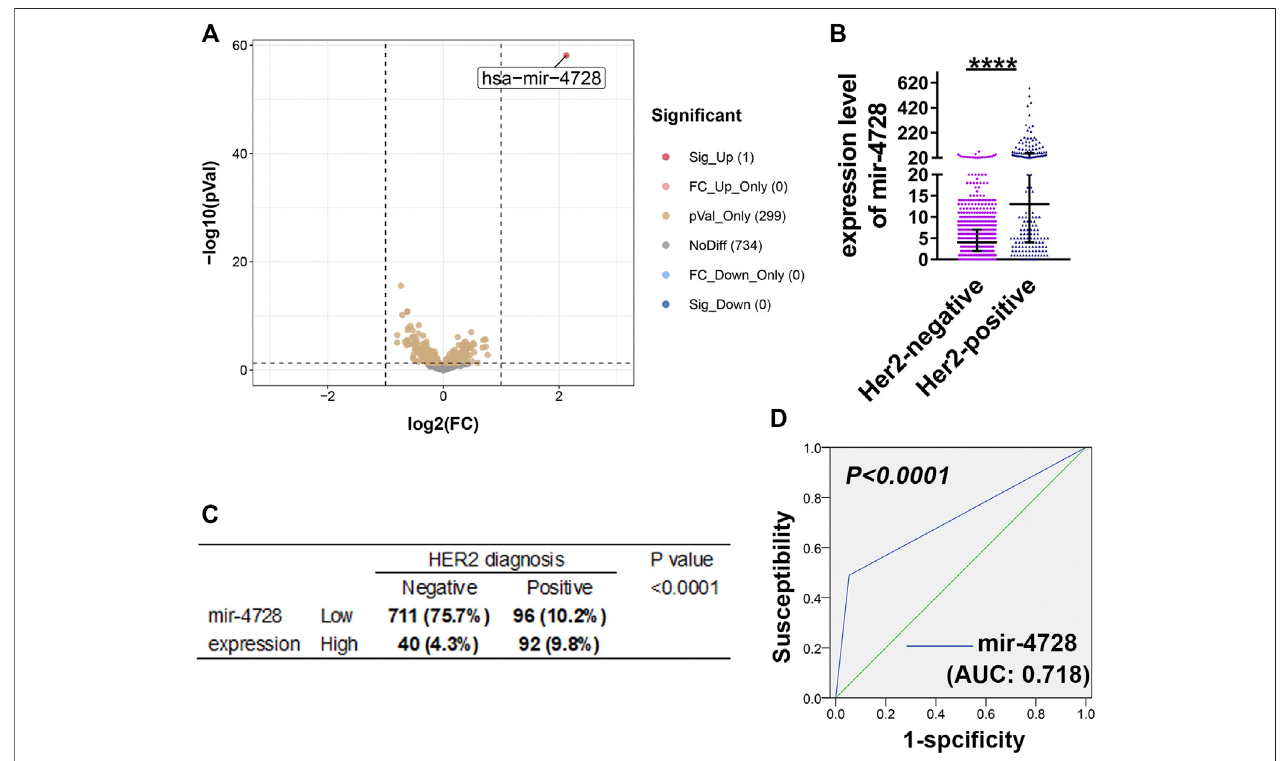
FIGURE 1 | Mir-4728 acts as a key marker in the diagnosis of HER2 status. (A) Volcano plot depicts the differentially expressed mirnas between breast cancer patients with HER2-positive status and HER2-negative status. (B) Mir-4728 is signi fi cantly upregulated in HER-2 positive patients in comparison with HER2-negative patients. (C) Correlation analysis between the mir-4728 expression and HER-2 status diagnosis in breast cancer patients. (D) The area under the receiver operating characteristic (AUROC) shows that mir-4728 signi fi cantly predicts the HER-2 status diagnosis in breast cancer